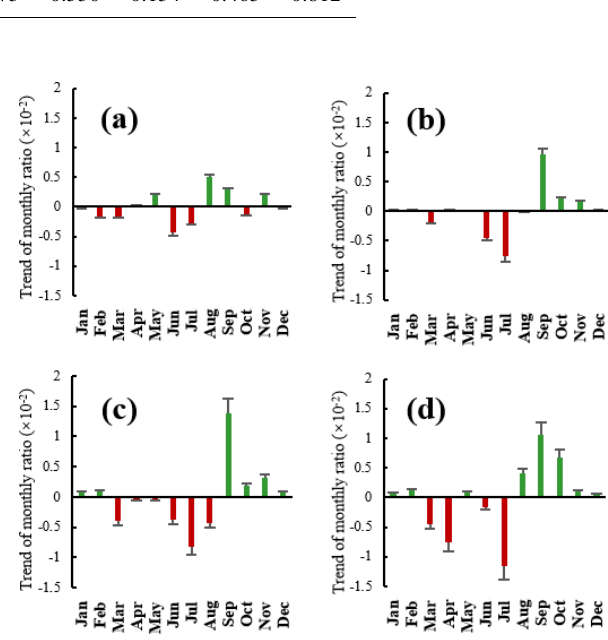
Figure 5. Trends in the ratio of the observed monthly to annual precipitation of subregions in the (a) source region, (b) TNH–TDG, (c) TDG–LM, and (d) LM–HYK. The error bars represent the 1 standard deviation (SD).